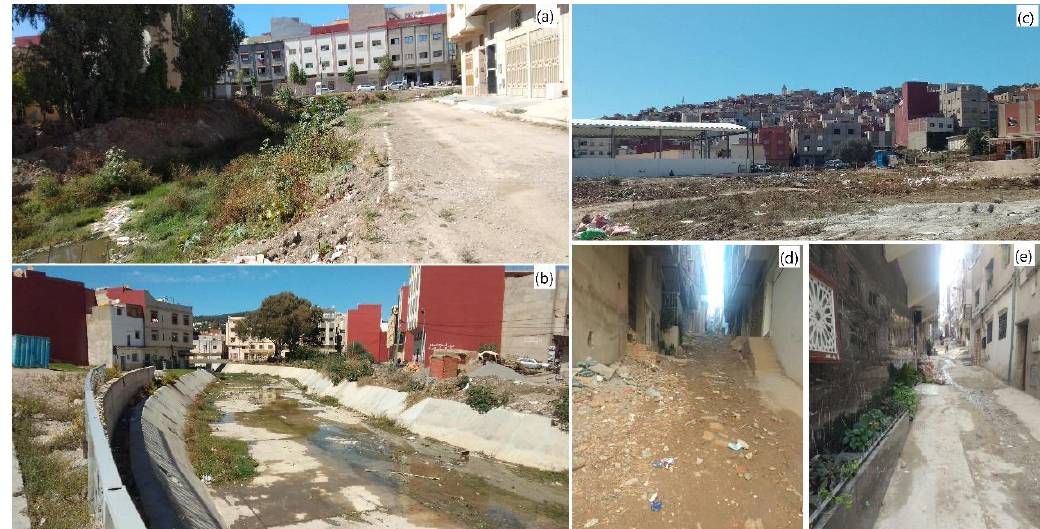
Figure 8. Urban flooding vulnerability map obtained from ( a ) linear discriminant analysis (LDA); ( b ) logistic regression (LR); ( c ) classification and regression tree (CART); ( d ) Support vector machine (SVM).